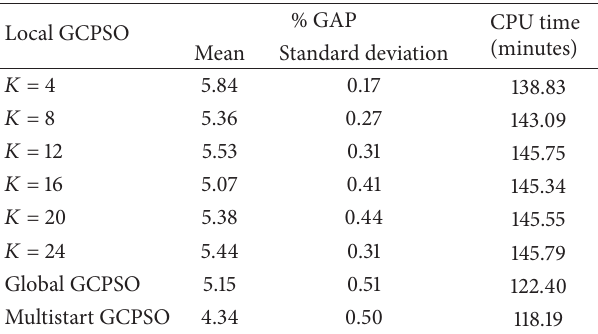
Table 3: Numerical results of different variants of the GCPSO algorithm in the case of problem 1.